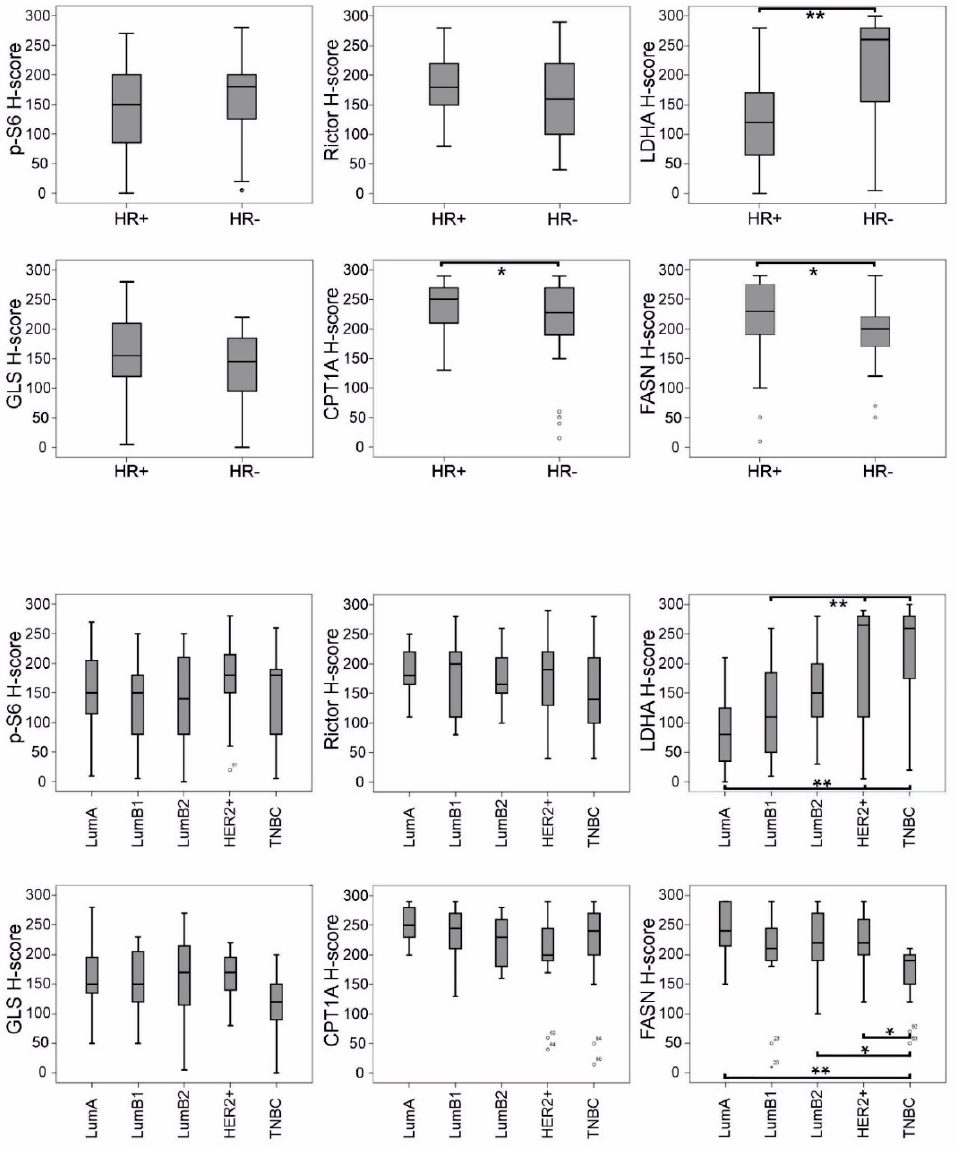
Figure 5. Correlation of mTOR pathway markers and metabolic enzymes (determined by IHC) with subtype distribution in breast cancer. H-scores for LDHA, CPT1A and FASN showed significant correlation with hormone receptor status (HR + or HR-). LDHA H-scores increased from luminal A (LumA) to triple-negative breast cancer (TNBC) and, conversely, FASN H-scores decreased from LumA to TNBC (** p < 0.01, * p < 0.05, statistically significant). Ranges with median values are shown; bare circles represent outlier breast cancer cases.